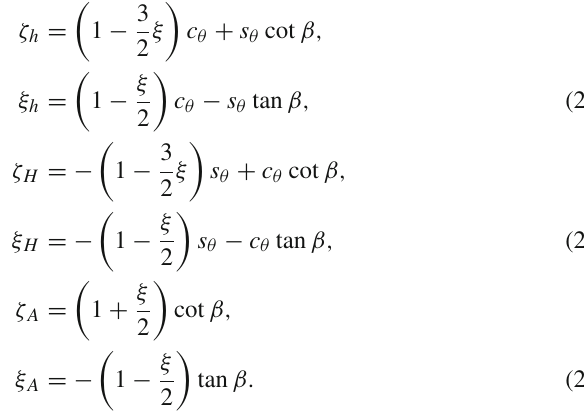
, Q d and L L are L L